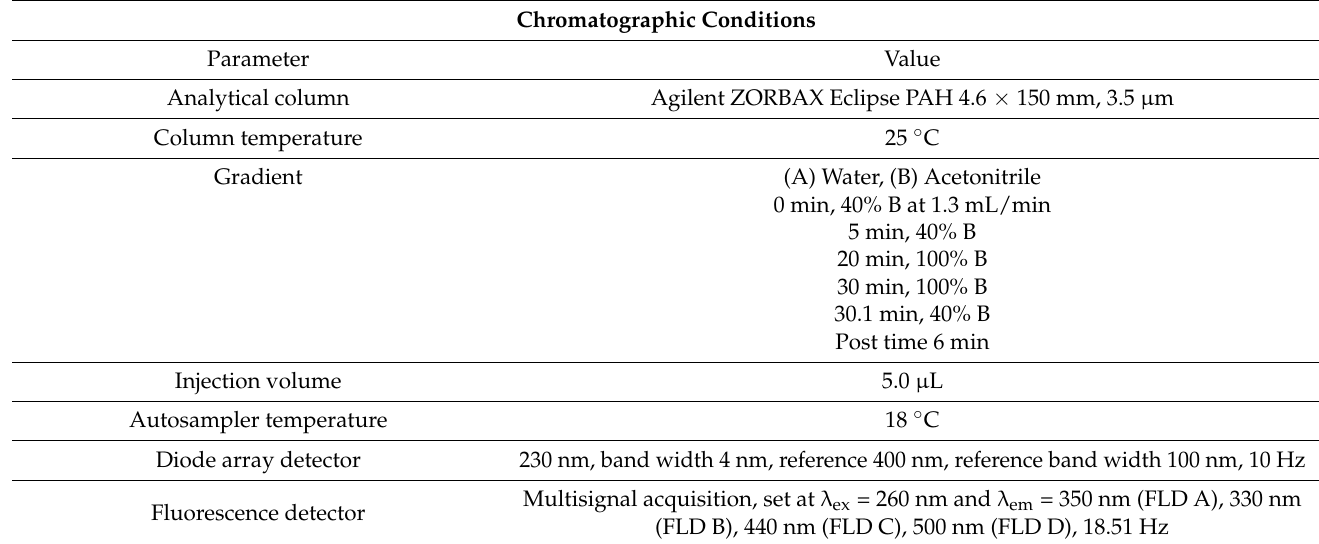
Table 3. Separation parameters of HPLC/FLD